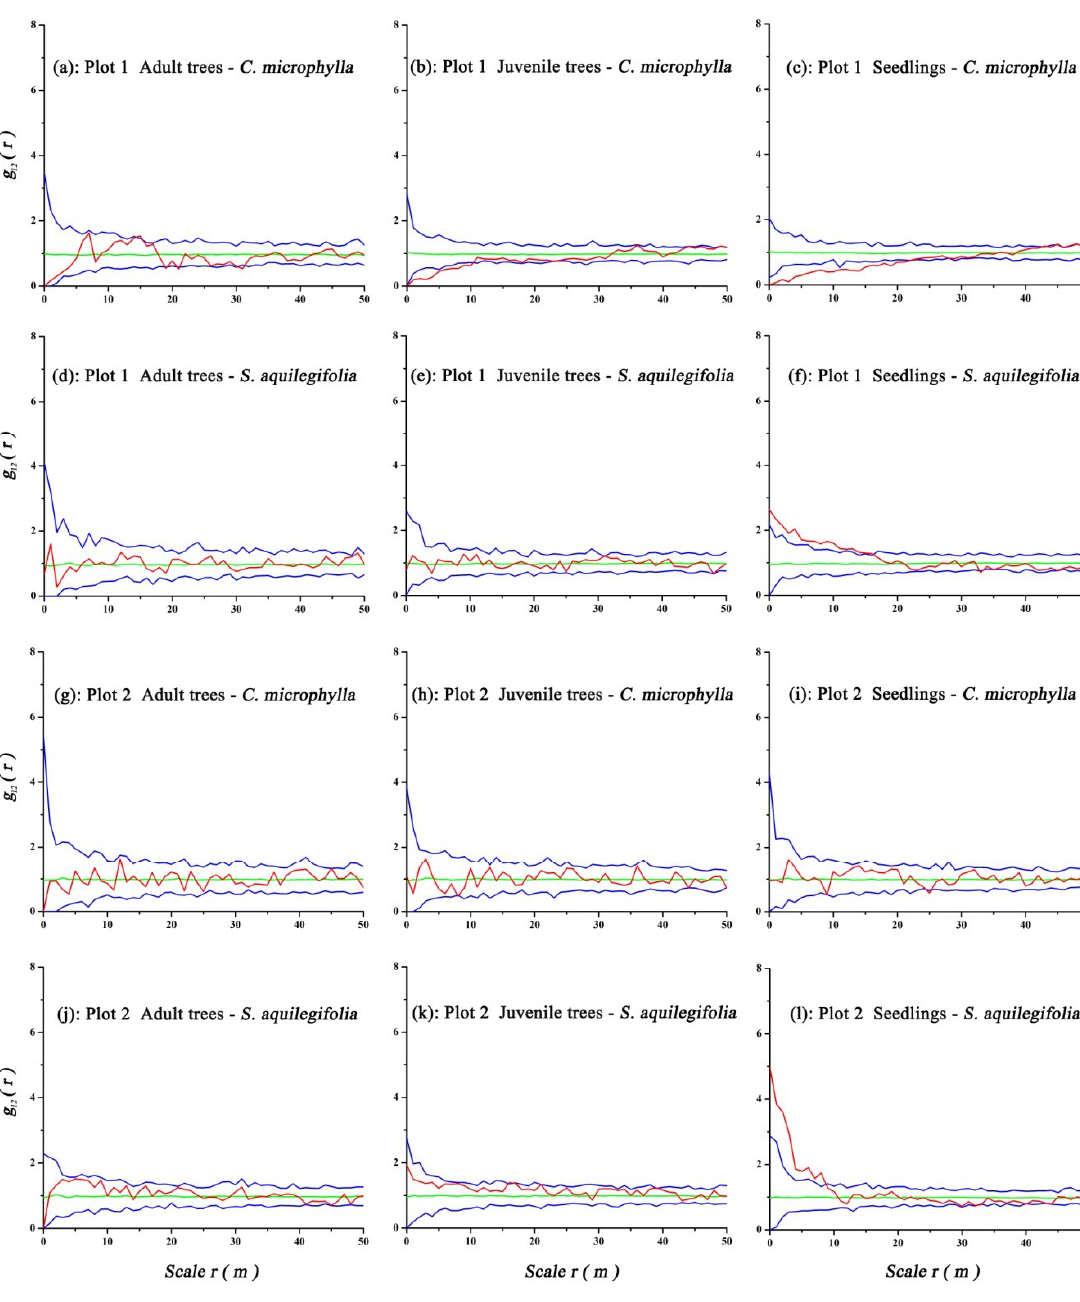
Figure 7. Spatial associations of U. pumila trees and shrubs with the CSR null model. Graph colors are defined in Figure 4.